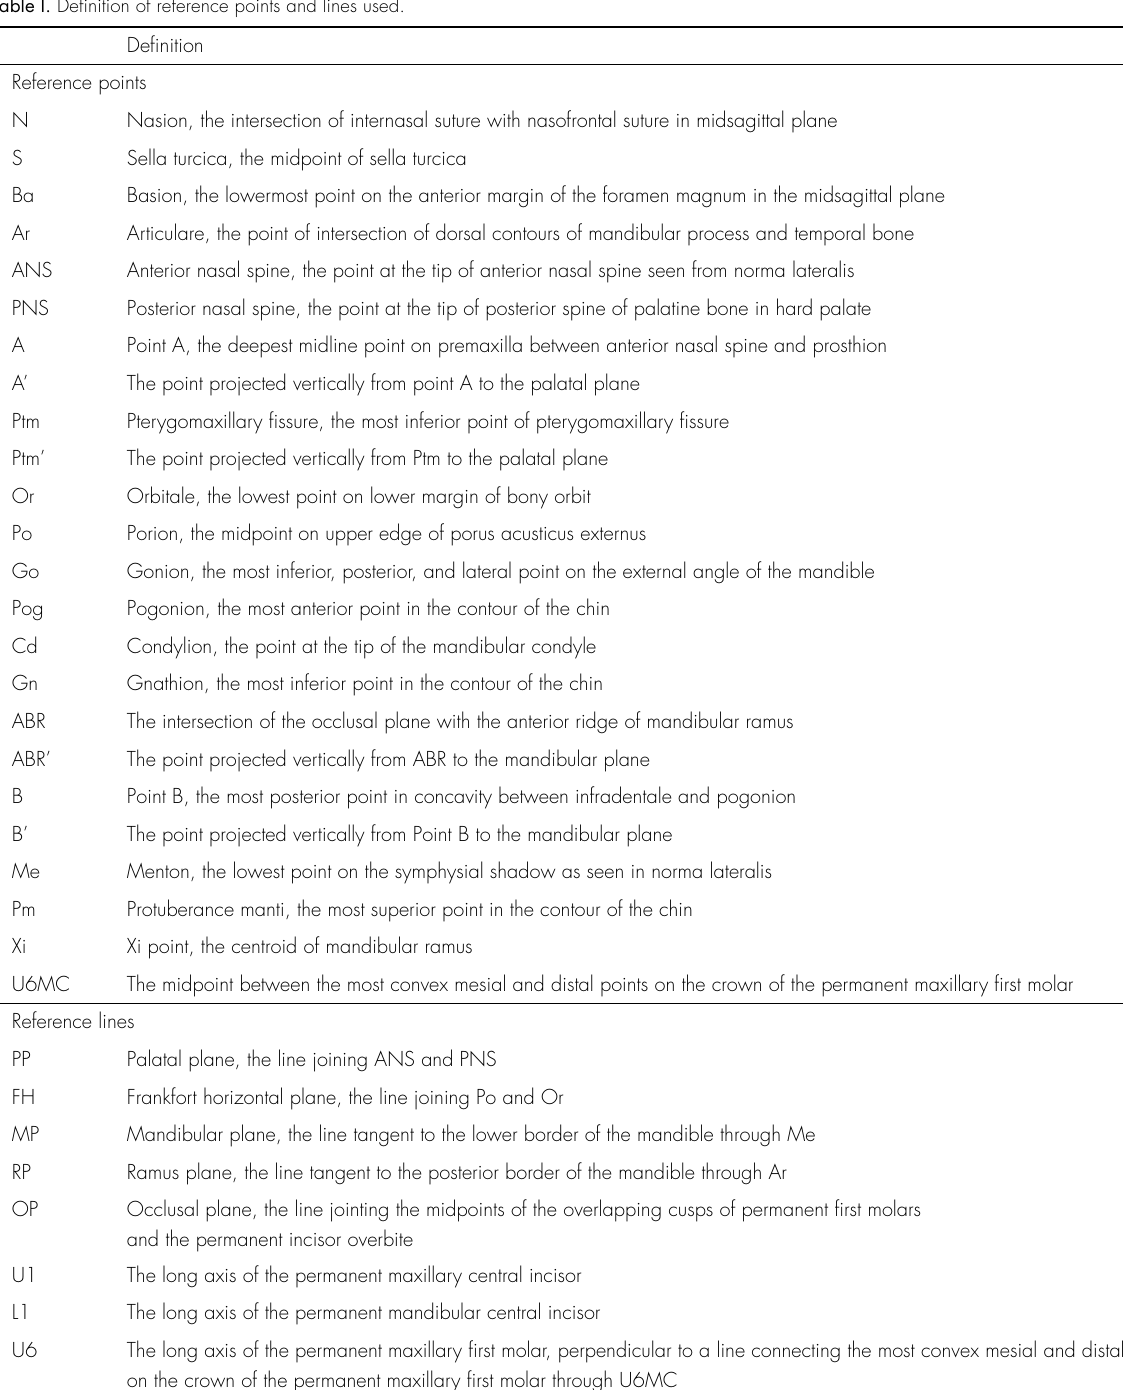
Table I. Definition of reference points and lines